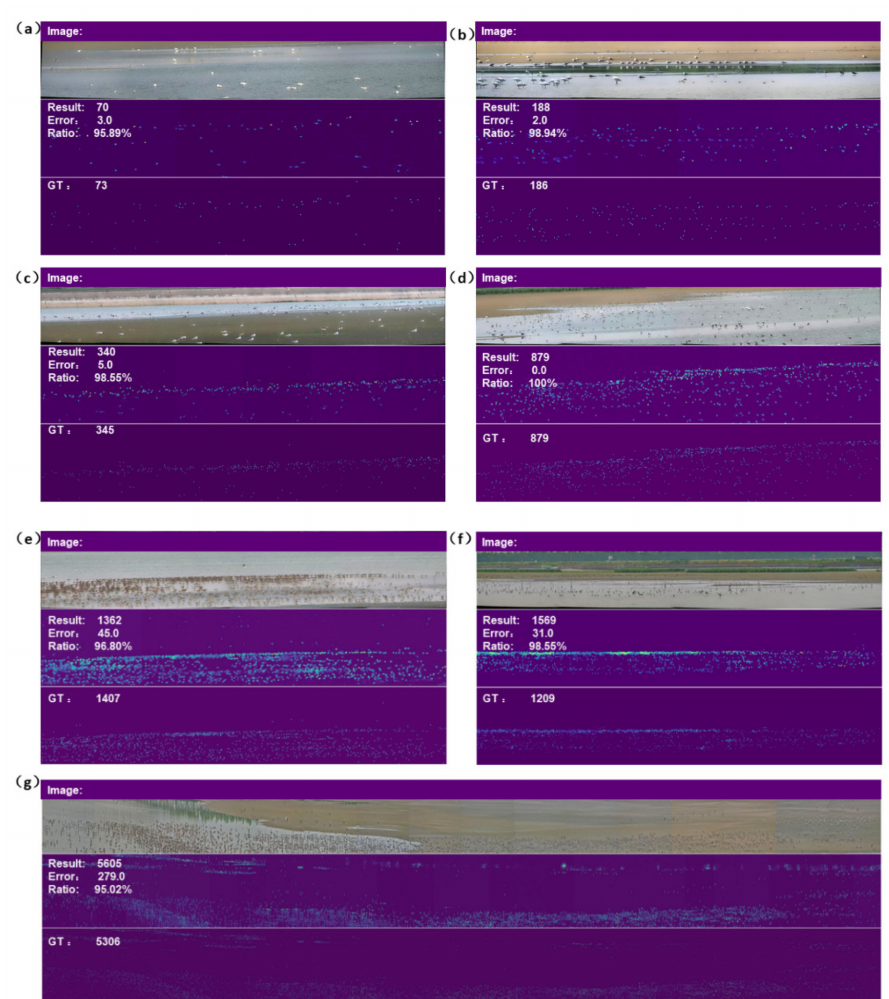
Figure 8. Examples of model output of density map and bird counting. We visualize the results of different orders of magnitude images to demonstrate the adaptability and practicability of our algorithm: ( a – g ) represent seven typical samples of different orders of magnitude, each consisting of the original image (top) and the resultant density map (middle) and total bird count in the image